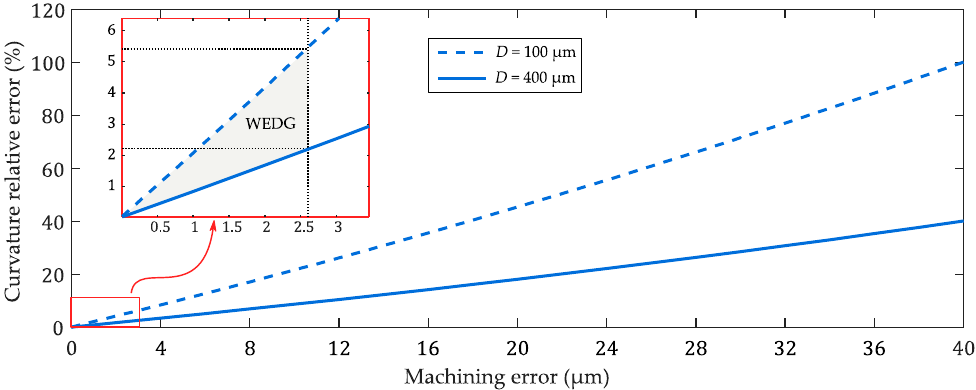
Figure 6. Effect of the machining error on the curvature relative error (CRE). In the graph, the calculated CRE of segments with inner cavity diameter D equal to 100 µm and 400 µm is shown.